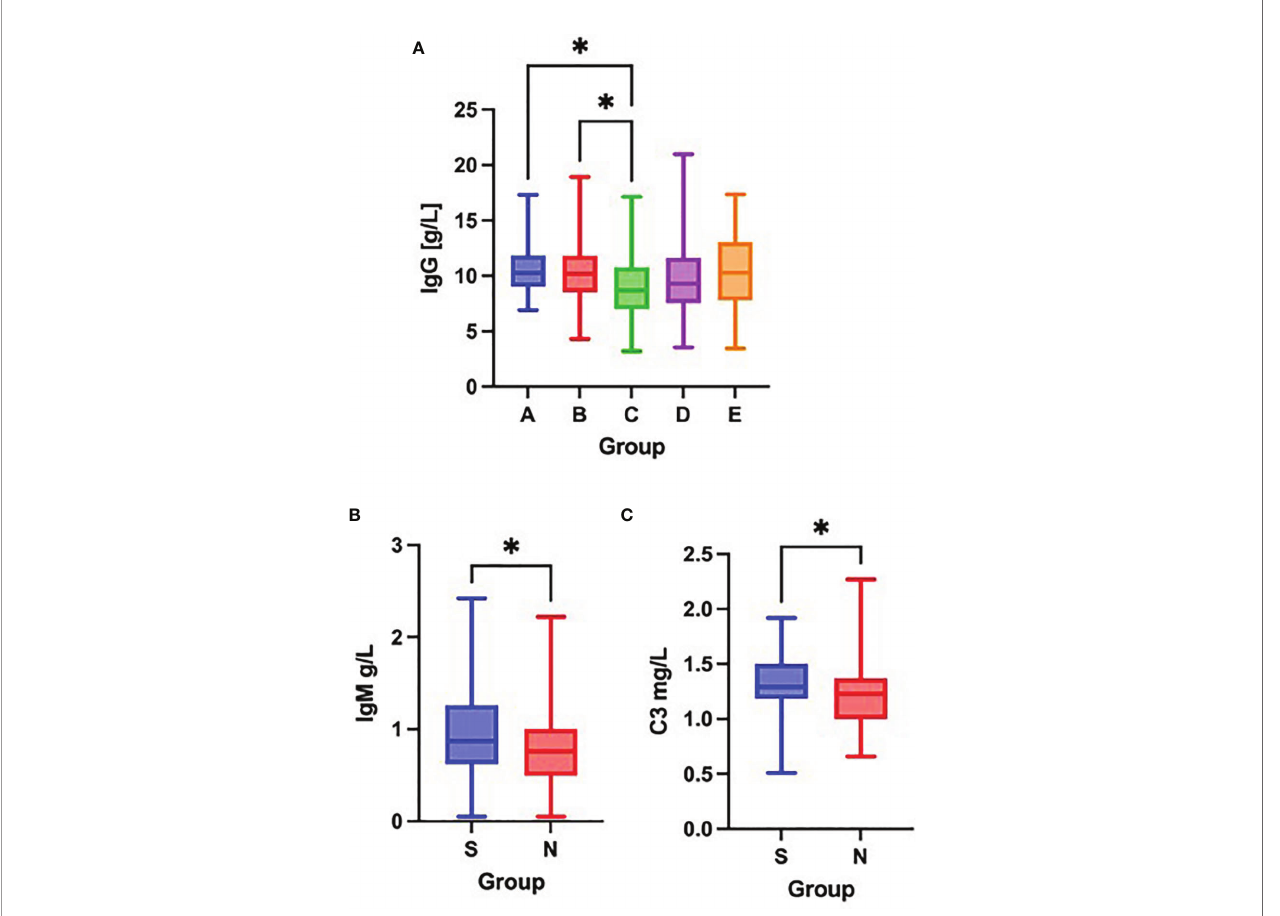
FIGURE 2 | Differences in the serum concentration of IgG (A) among groups A – E (Kruskal-Wallis test), differences in the serum concentration of IgM (B) and C3 (C) between survivors [S] and non-survivors [N] (Mann-Whitney test) on admission to the hospital. *p <